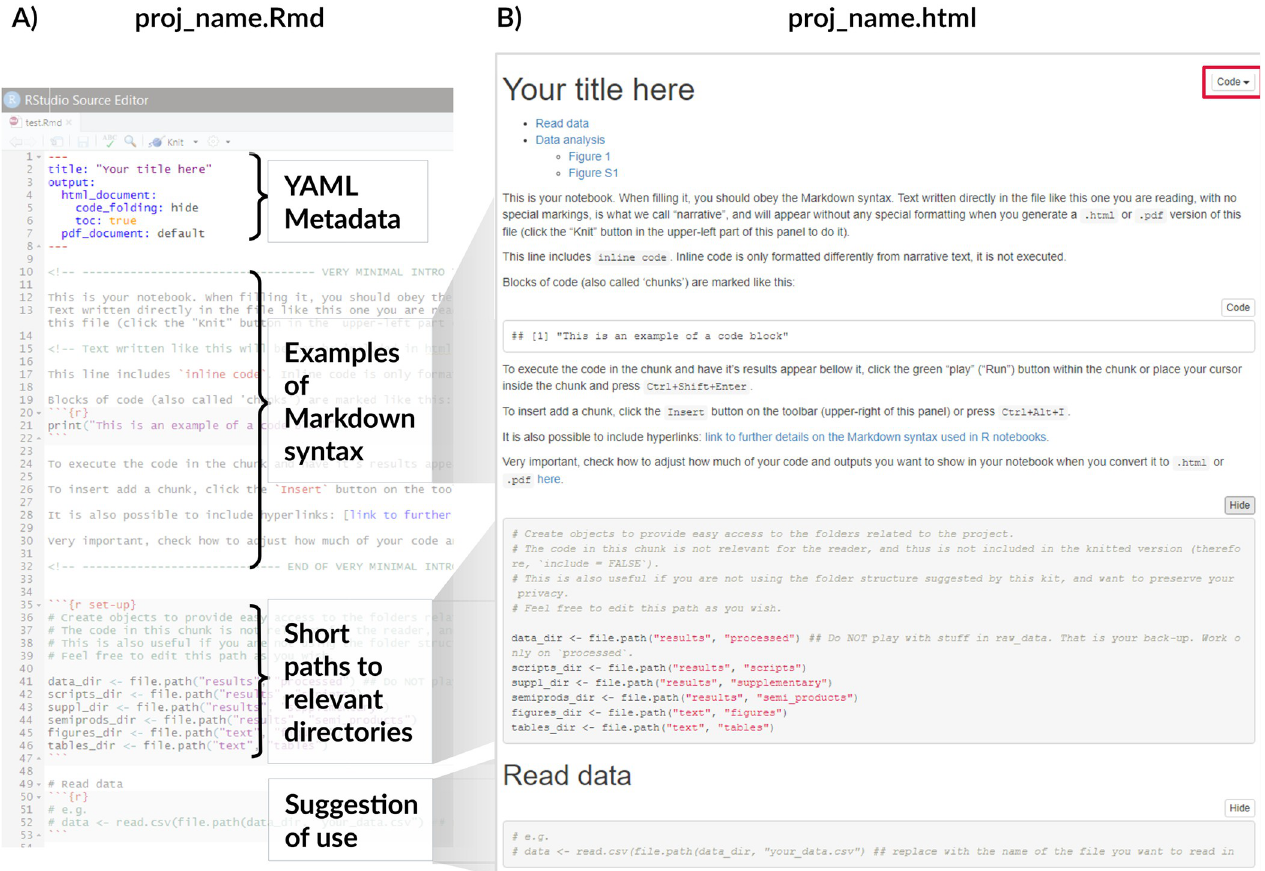
Fig 3. Comparison between the Rnotebook file available for editing (A) and the rendered html version (B). The function in set_kit.R creates an.Rmd file (A) with basic metadata (title and minimal formatting of the rendered file), a brief tutorial on the Markdown syntax, paths to the most relevant folders, and suggestions of use. In the.html version (B), one can see how text and code are converted and combined, as well as a couple of features available in Rnotebooks: a table of contents, just below the title (defined by the toc argument set to true in the YAML section of the Rnotebook file), and a code button, that hides the blocks of code by default, to facilitate reading (defined by the code_folding argument set to hide in the YAML section). The video accompanying this tutorial details how the document works (available in https://github.com/FellowsFreiesWissen/computational_notebooks).